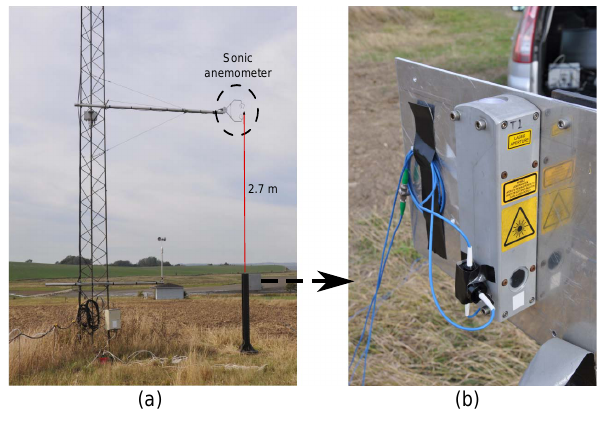
Figure 4. Field campaign at Risø campus of the Technical Uni- versity of Denmark. (a) shows the position of the ICDL’s output antenna with respect to the sonic anemometer. (b) is an expanded view of the mounting plate for the antenna, viewed from the back- side of the plate seen in (a)